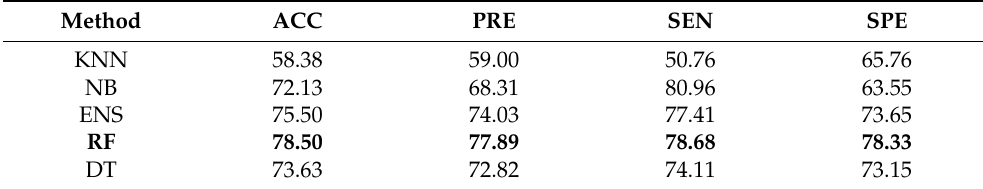
Table A6. AF detection performance based on energy features.